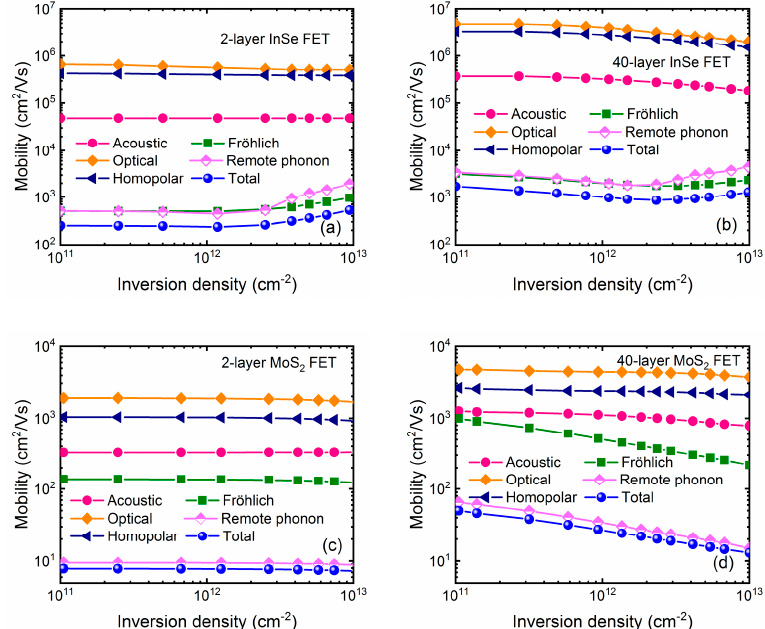
Figure 5. Contributions of each scattering process to the total mobility corresponding to Figure 4a,c for InSe and MoS 2 FET with HfO 2 dielectric respectively. ( a ) 2-layer InSe FET. ( b ) 40-layer InSe FET. for InSe and MoS 2 FET with HfO 2 dielectric respectively. ( a ) 2 ‐ layer InSe FET. ( b ) 40 ‐ layer InSe FET. ( c ) 2-layer MoS 2 FET. ( d ) 40-layer MoS 2 ( c ) 2 ‐ layer MoS 2 FET. ( d ) 40 ‐ layer MoS 2 FET.